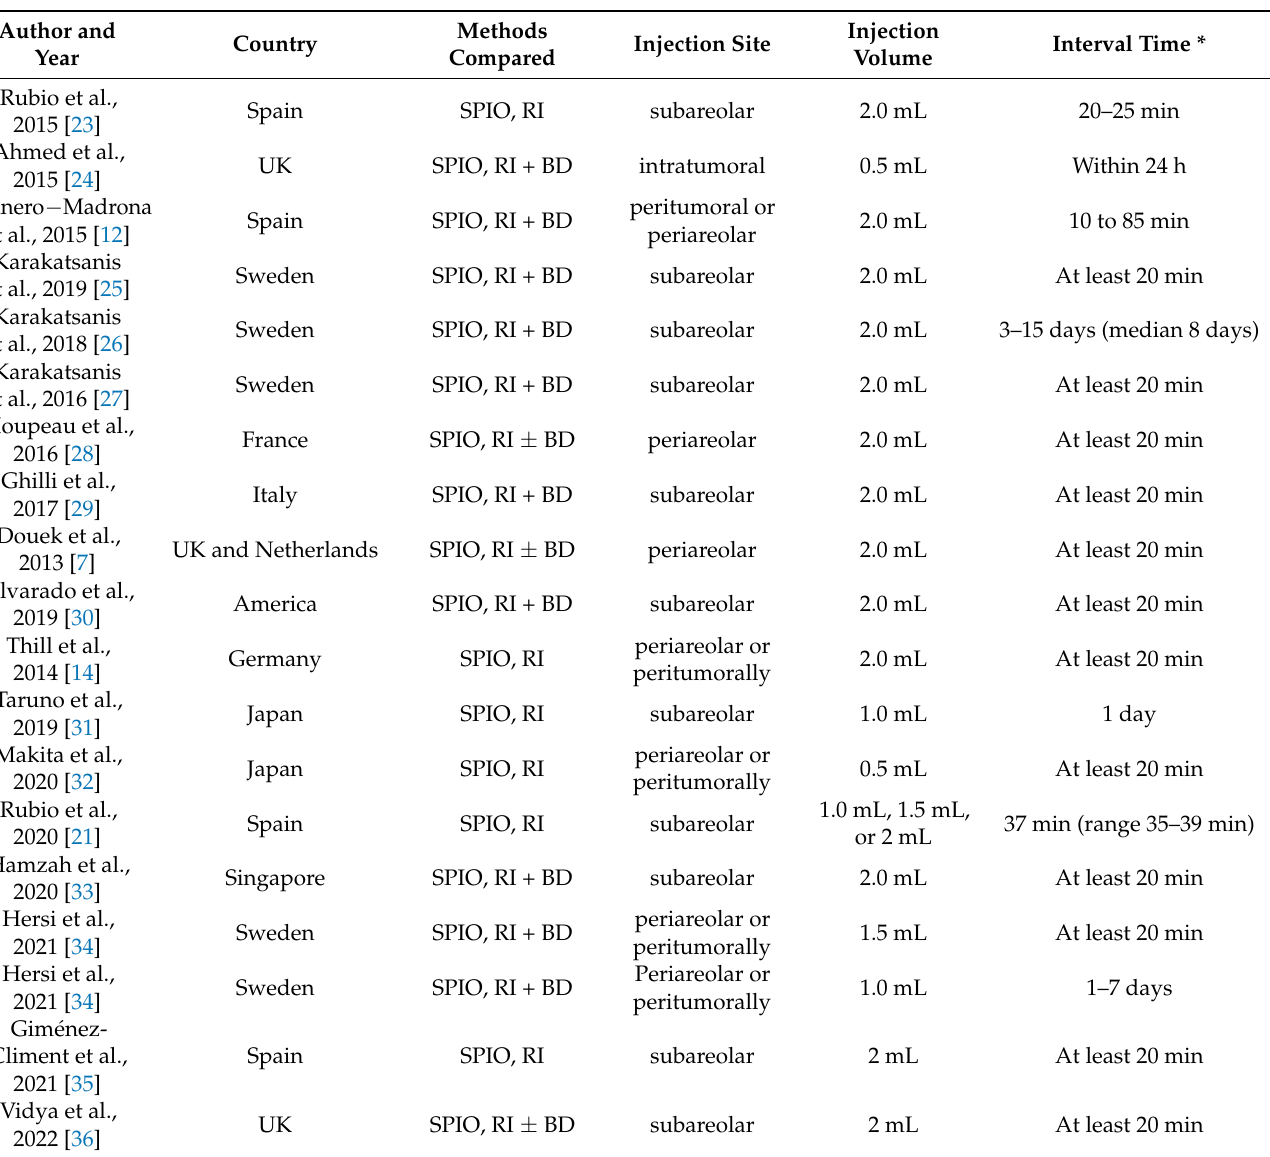
Table 1. Baseline